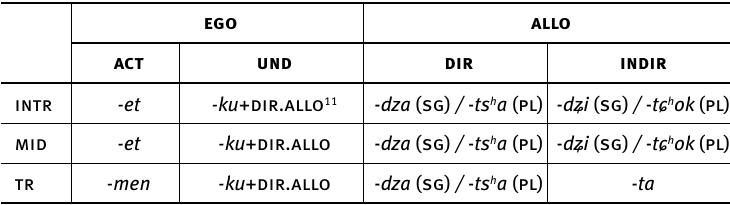
Table 6. Egophoricity and evidentiality in Bunan (past)10 ego